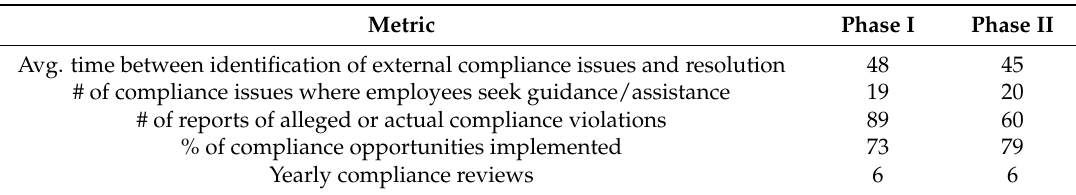
Table 4. Compliance metrics, comparison of phases. Case Study 2.